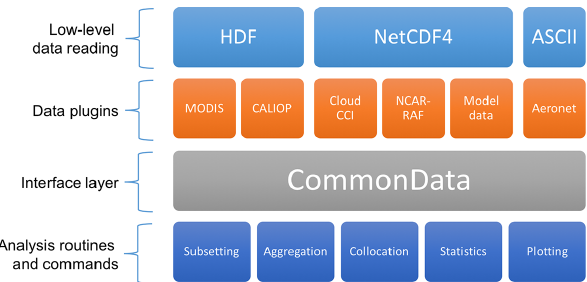
Figure 1. An illustration of the architecture of CIS demonstrating the different components in the modular